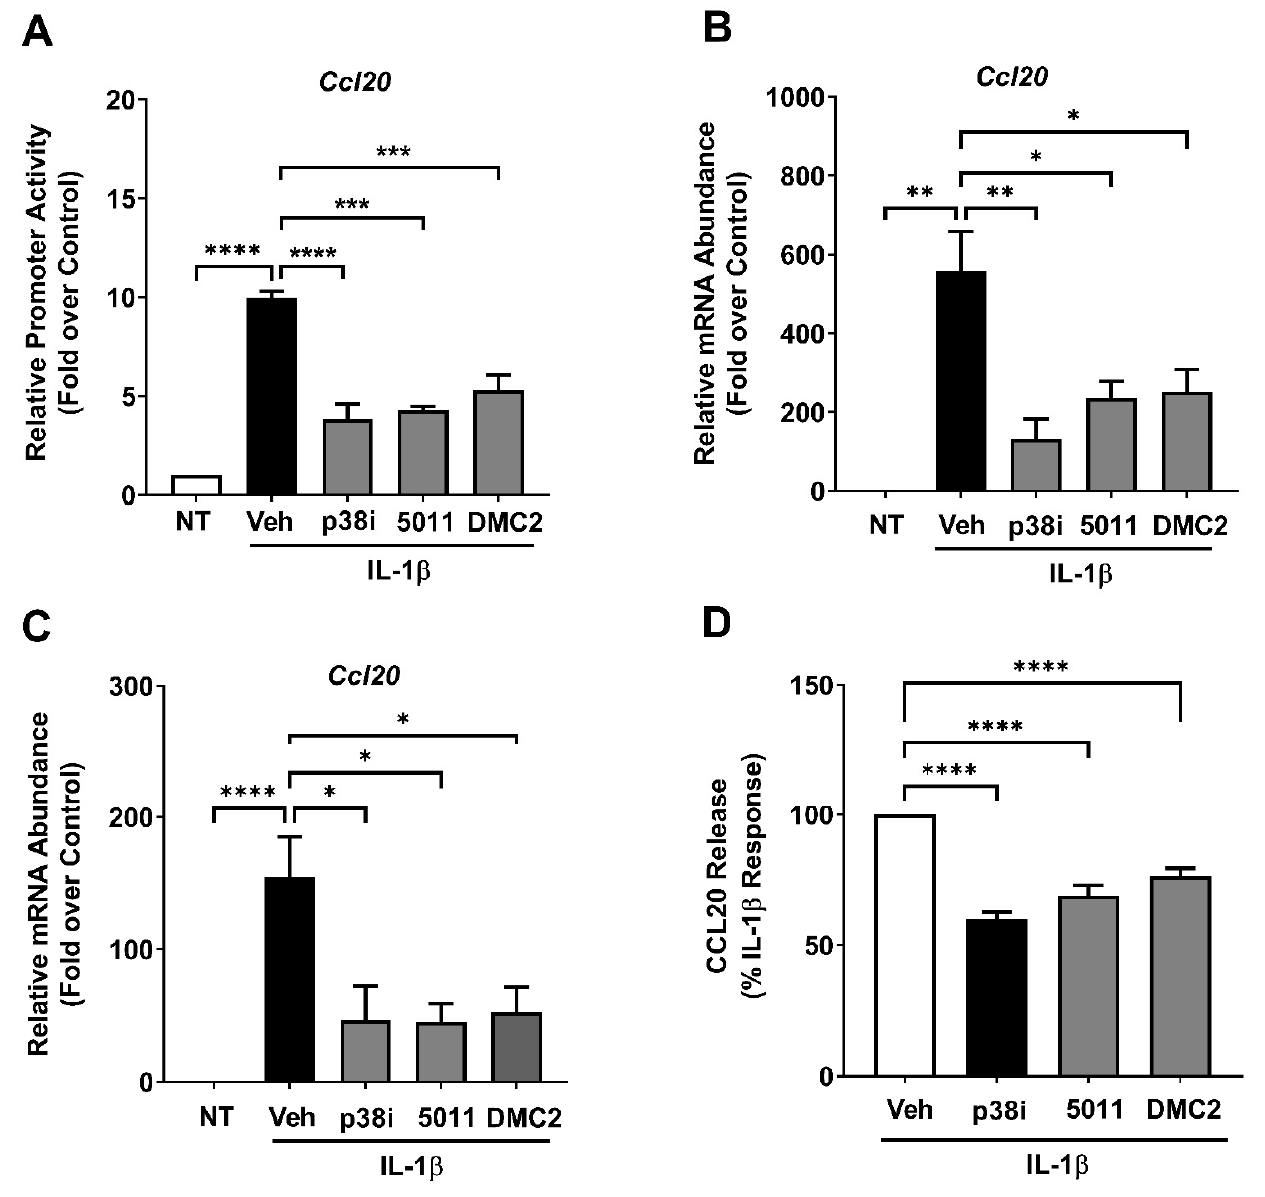
Figure 5. PMI 5011 and DMC2 reduce Ccl20 gene expression and protein secretion. ( A ) 832/13 cells were transfected with a plasmid containing the − 3 kb Ccl20 promoter driving a luciferase reporter. 24 h after being transfected, the cells were treated with 10 µ M of the p38 MAPK inhibitor SB202190 (p38i), 10 µ g/mL PMI5011, or 35 µ M DMC2 for one hour, followed by exposure to 1 ng/mL IL-1 β for 4 h. Luciferase activity is plotted as the fold response over untreated (no IL-1 β ) veh control. ( B ) 832/13 cells were treated with 10 μ M of the p38 MAPK inhibitor SB202190, 10 μ g/mL PMI5011, or 35 μ M DMC2 for one hour, followed by exposure to 1 ng/mL IL-1 β for 3 h. Expression of the Ccl20 transcript was measured by qPCR. ( C ) Isolated mouse islets were treated with 10 μ M p38i, 10 μ g/mL PMI5011, or 35 μ M DMC2 for one hour, followed by exposure to 1 ng/mL IL-1 β for 3h. Expression of the Ccl20 gene was analyzed by qPCR. ( D ) 832/13 cells were treated with 10 μ M of the p38 MAPK